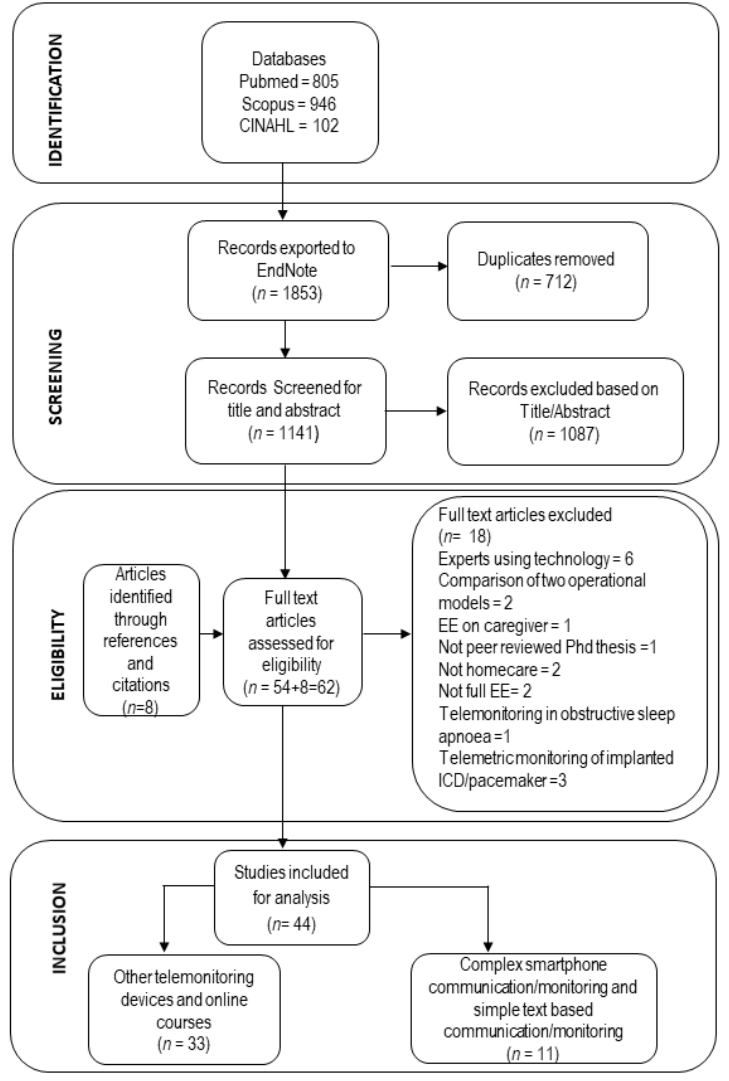
Figure 1. PRISMA flow chart of study selection process.